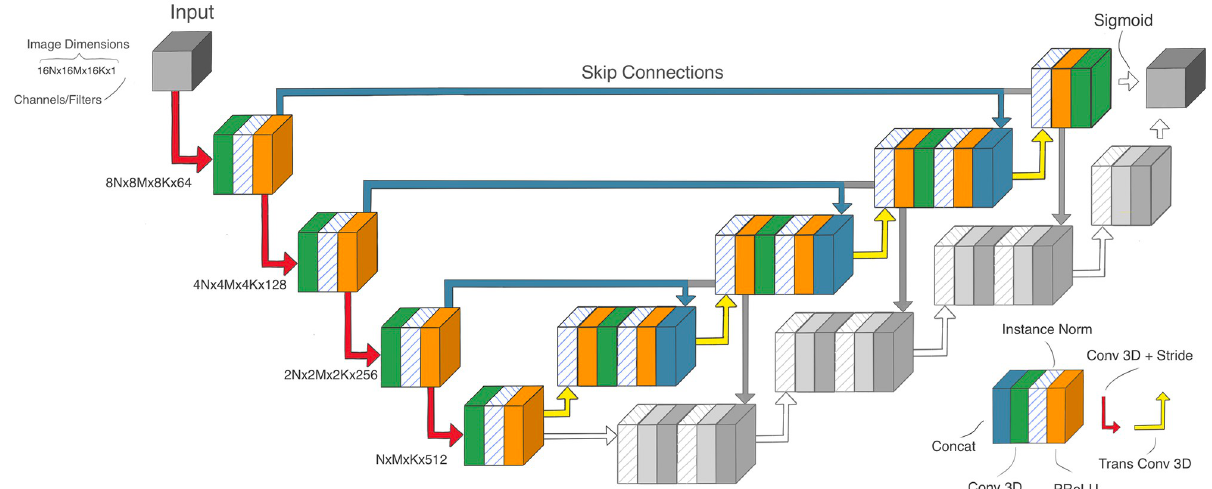
Fig 2. The network architectures. The single output (SO) Student is highlighted in colors whereas the decoder branch of the dual output (DO) Student is implicated in gray. For the DO Student the ouput of the two decoder branches are concatenated to form a dual-channeled output. The teachers have the same architecture as the SO Student, but with three downsamplings rather than